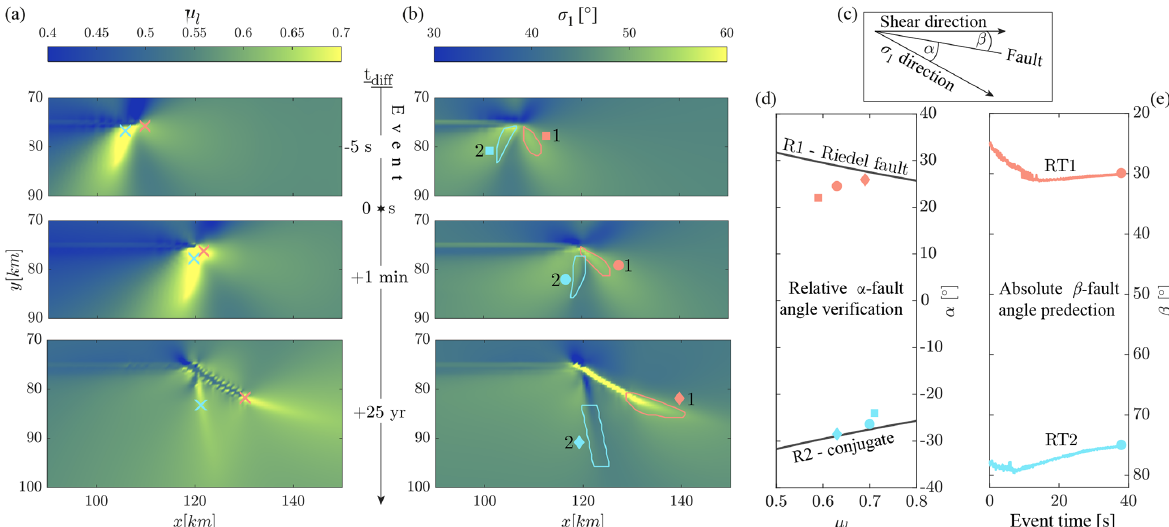
Figure 4. Evolution of the local friction coefficient and stress orientation of model RT over time and the prediction of the absolute fault angle. The three different times are (1) 5s before fault propagation (symbol (cid:3) ), (2) 1min after the initiation of the first fault propagation (symbol ◦ ) and (3) 25 years after the initial fault propagation (symbol (cid:5) ). Red represents the Coulomb angle of R1, and turquoise refers to the conjugate fault R2. (a) Snapshot zooms of the local friction distribution µ l at different times. Crosses indicate the location of the two maxima of µ l at the rupture tip or at the tip of the newly formed fault. (b) Snapshot zooms of the distribution of the maximum compressive stress orientation σ 1 at different times. Red and turquoise polygons indicate the locations around the frictional maxima inside the two stress lobes where µ l and σ 1 are sampled and averaged according to 2 standard deviations of the mean (95th percentile). (c) Schematic geometrical relation in physical space between horizontal shear direction, σ 1 direction and forming fault. β represents the absolute fault angle, and α is the angle between the fault and the σ 1 direction such that α 1 , 2 = σ 1 − β 1 , 2 . (d) Relation between averaged local friction coefficient µ l and fault angle α 1 , 2 , av which is obtained from the average σ 1 directions for the three different instants shown in (a) and (b) for R1 and R2, respectively. The values from the frontal lobe result in the data converging on the R1 Riedel angle α 1 , and the data from the back lobe converge on the R2 conjugate α 2 . Black lines indicate the theoretical angle given by Eq. (18). (e) Prediction of the absolute fault angles β 1 , 2 for both RT1 and RT2 from sampling averages of µ l and σ 1 during the entire first dynamic